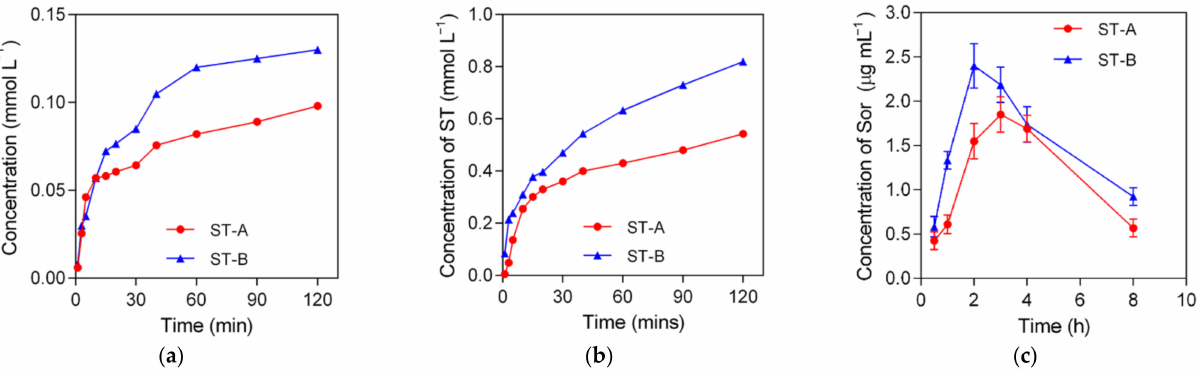
Figure 7. Dissolution rates of ST-A and ST-B in ( a ) water, ( b ) gastric juice pH 1.2 acid solution, and ( c ) in vivo pharmacoki- netic profiles of ST-A and